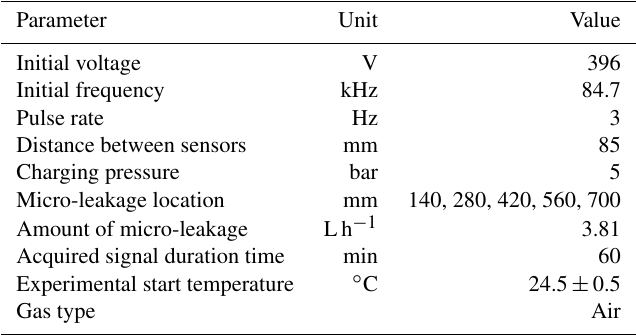
Table 3. Experimental